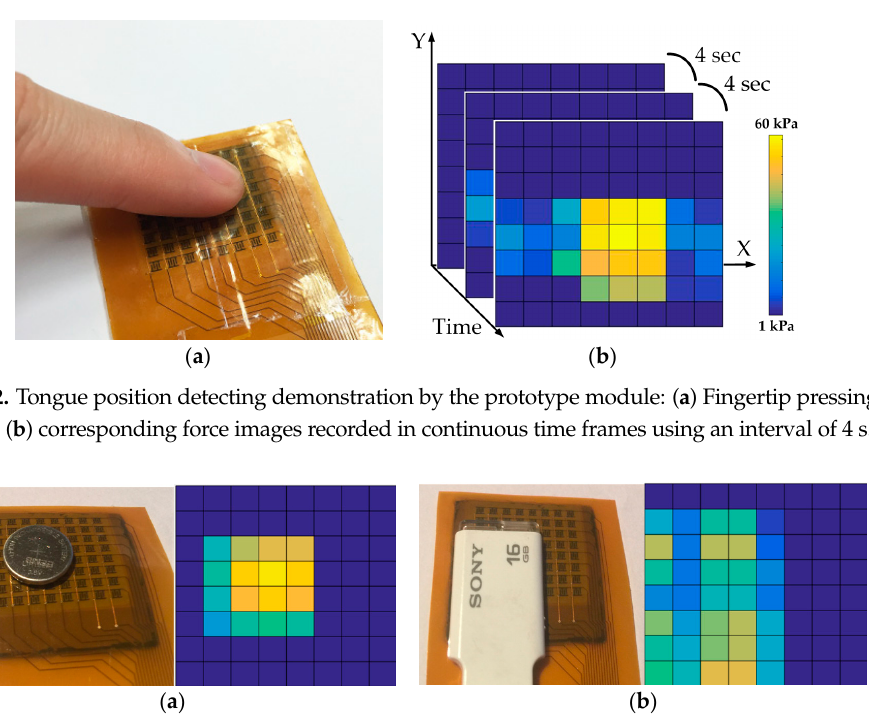
Figure 11. Measurement results of the prototype module in pressure detection: ( a ) Measured step transient response; ( b ) Measured characteristic of digital output code versus pressure.